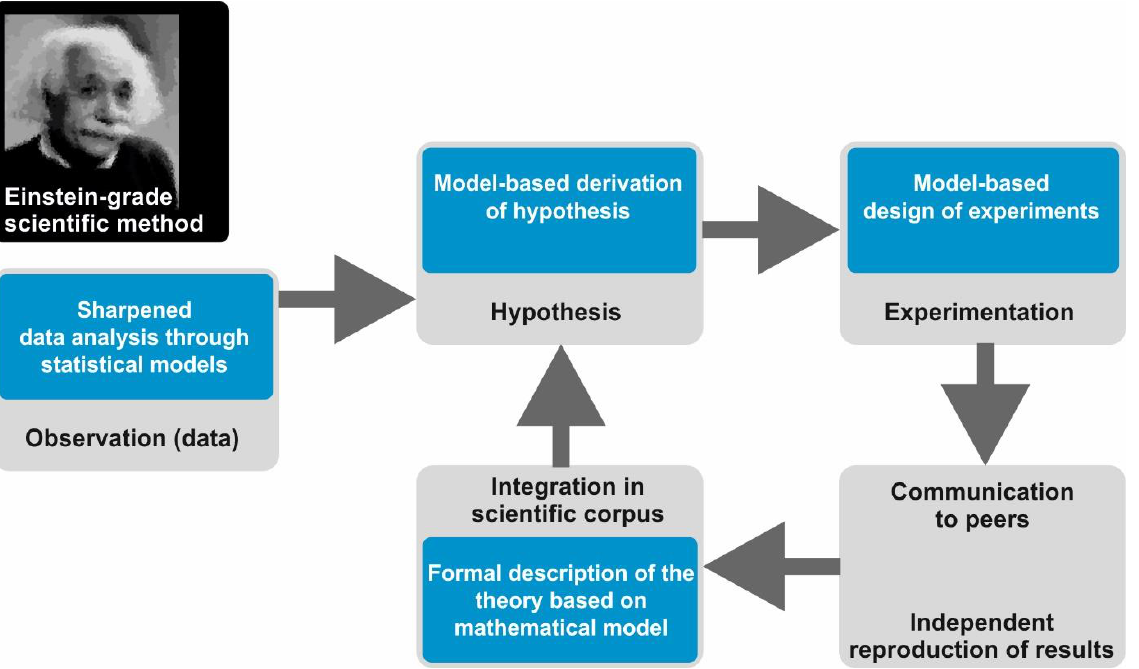
Figure 2. Sketch of the Einstein-grade scientific method (grey boxes) and the place that mathematical modelling occupies in it (blue boxes): the photograph of Albert Einstein is modified from the photo “Albert Einstein colorized” by Michael W. Gorth as stored in Wikimedia (CC-BY-SA-4.0, accession date: 10.08.2020; https://commons.wikimedia.org/wiki/File: